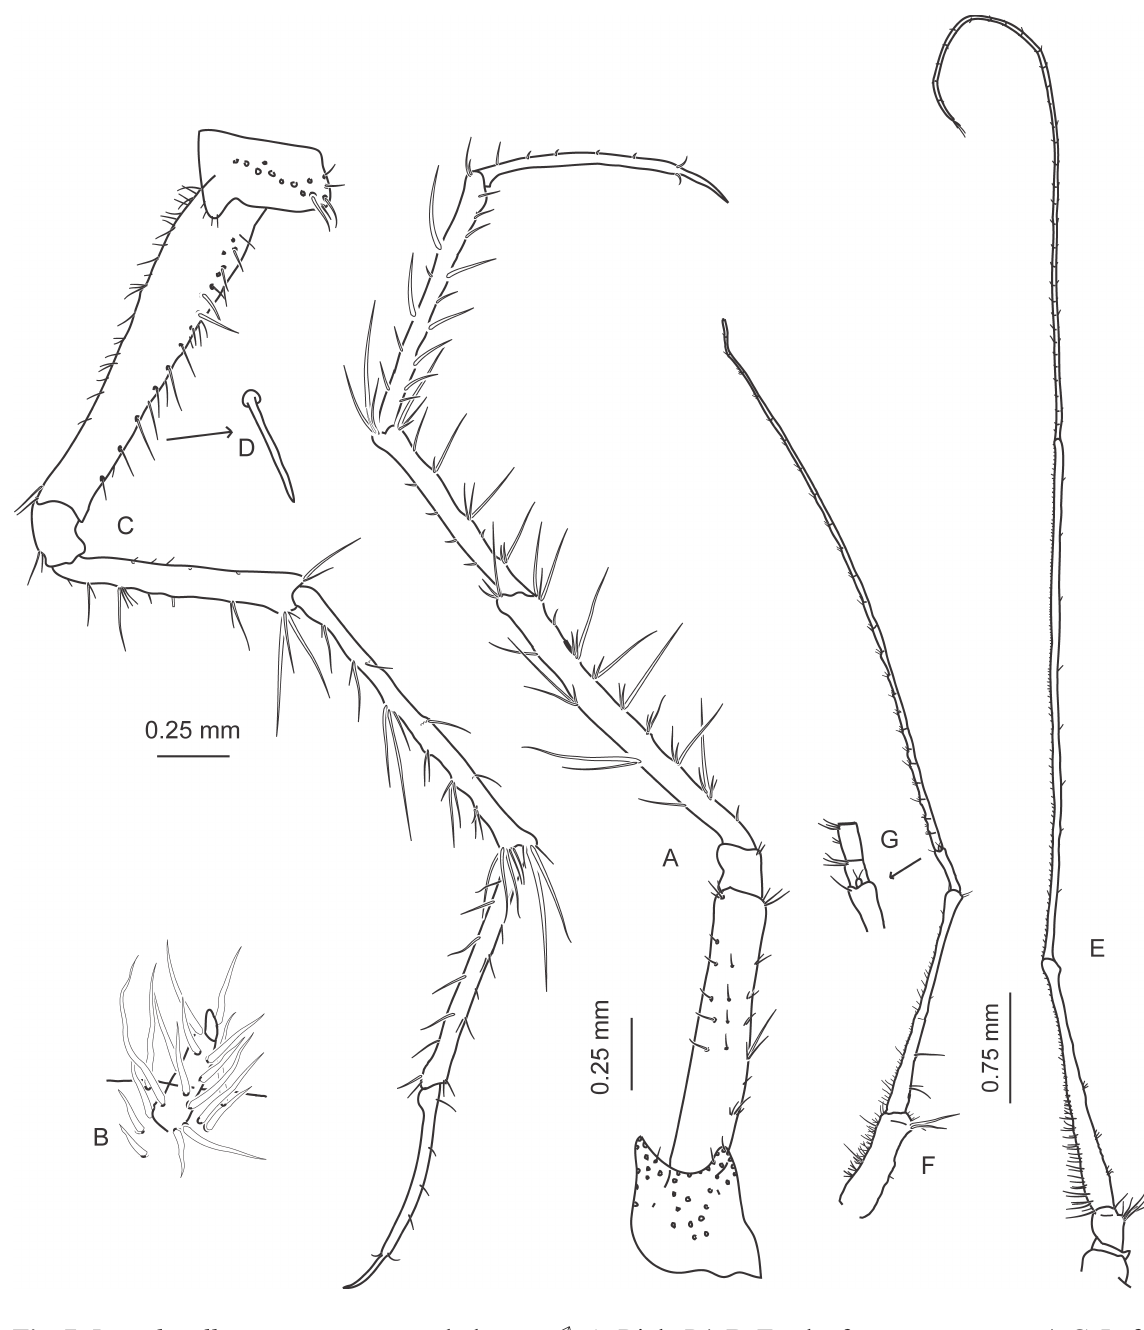
Fig. 7. Lepechinella norvegica sp. nov., holotype, ♂. A . Right P4. B . Tooth of peraeon segment 4. C . Left P6. D . Spine on basis of P6. E . Male A2. F . Male A1. G . Accessory flagellum on